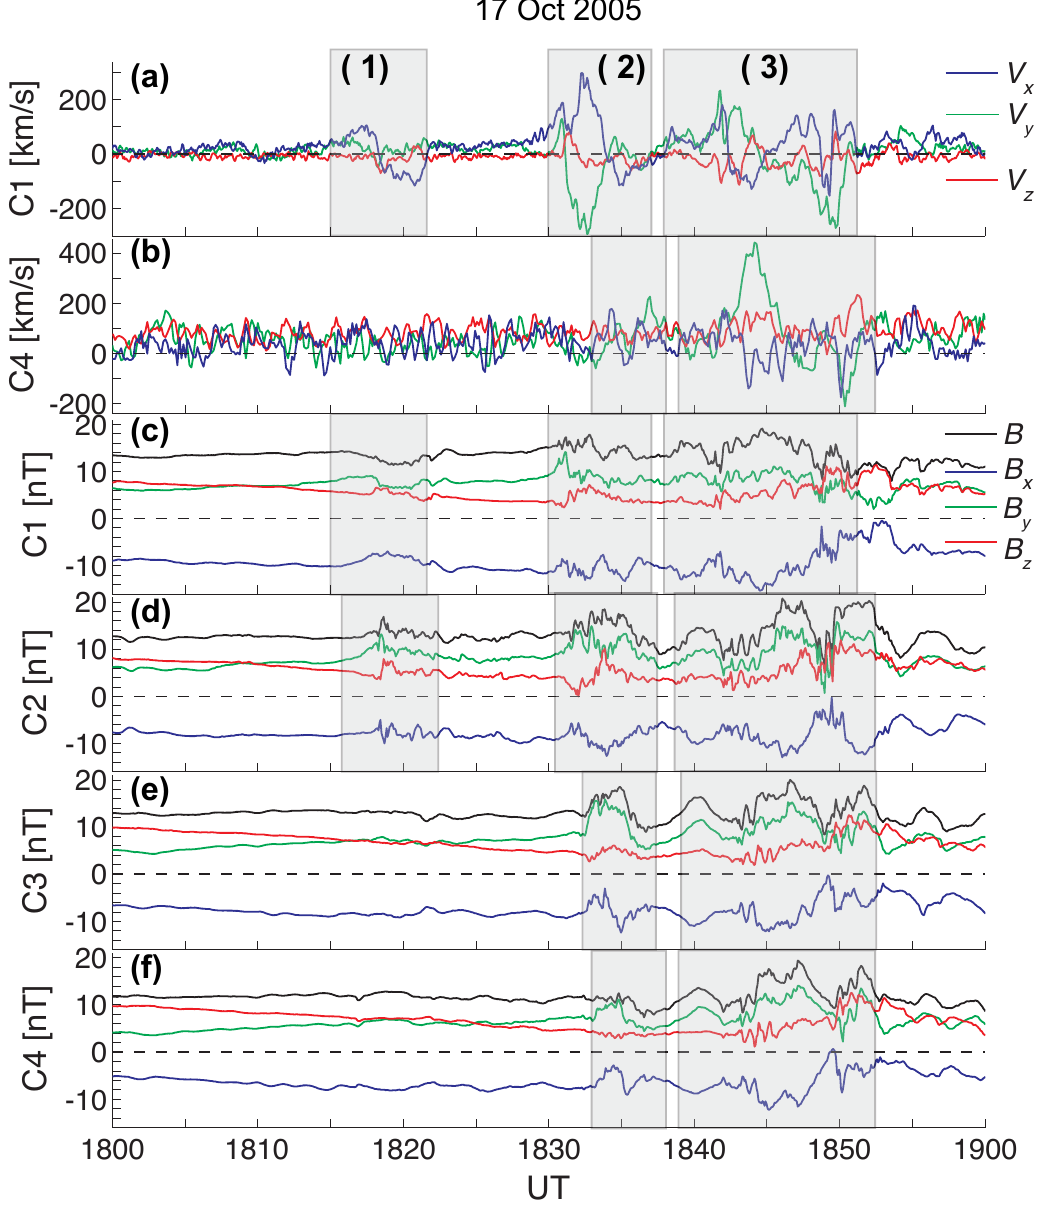
Fig. 4. Cluster data on 17 October 2005. (a) C1 CIS HIA velocity components in GSM. (b) C4 CIS CODIF proton velocity components in GSM. (c) – (f) Spin resolution magnetic field components by FGM in GSM. The vertical grey-shaded strips indicate the flow events under